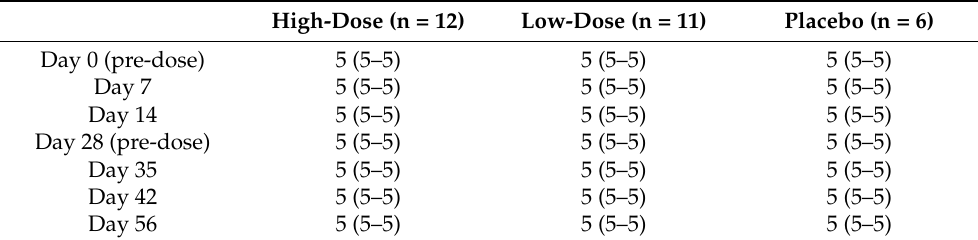
Table 6. Summary of live virus microneutralizing titre (MN titre).